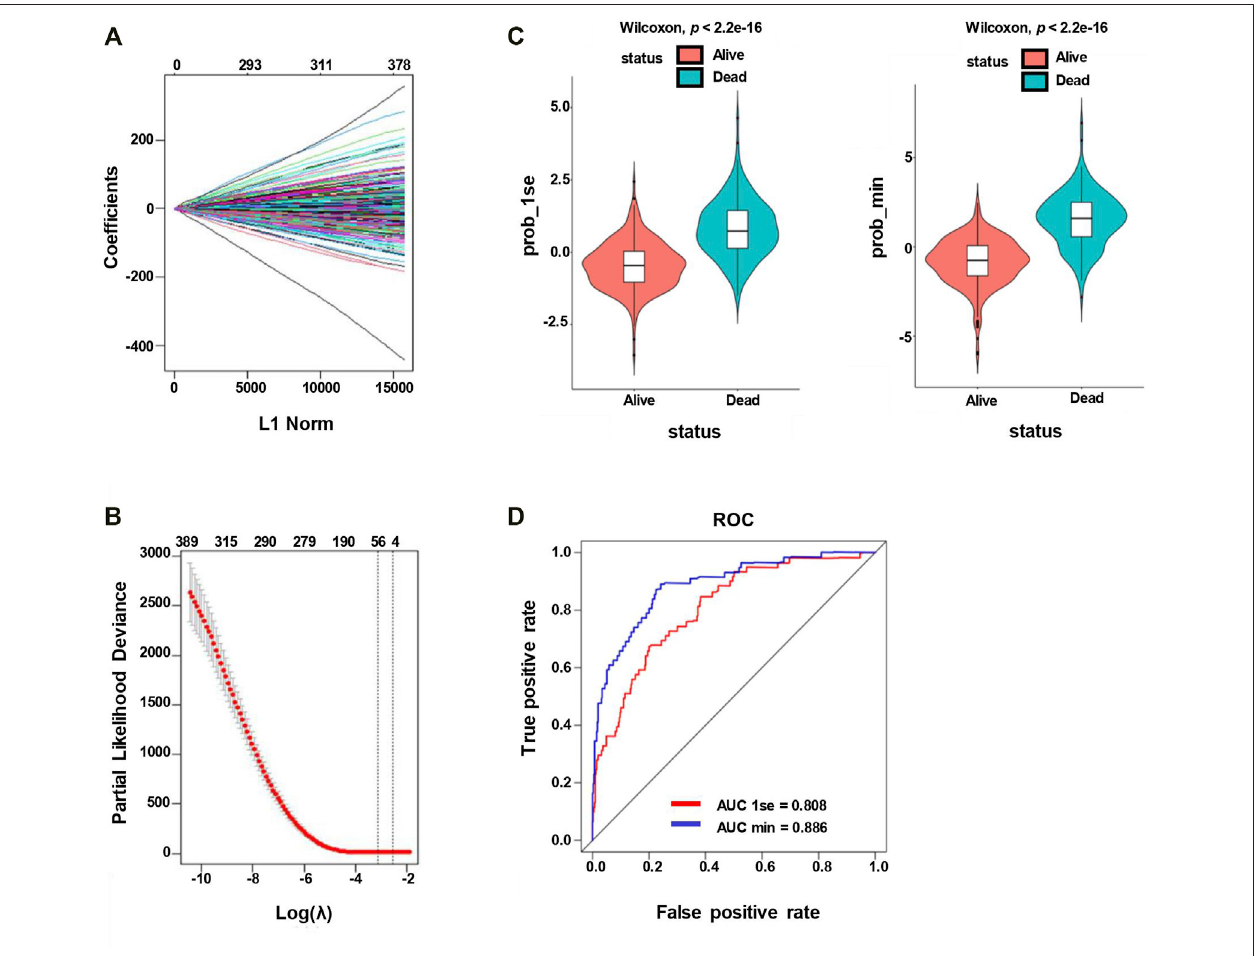
FIGURE 2 | Lasso penalized Cox regression analysis of SE-associated 512 genes. (A) Lasso coef fi cient pro fi les of the 512 SE-associated genes. (B) The identi fi cation of the best Lambda value. The left solid vertical line is the logarithm of lambda.min (48-gene group), and the right solid vertical line is the logarithm of lambda.1se (16-gene group). (C) The scatter plot of survival status of patients with diffuse large B-Cell lymphoma based on the 48-gene model (left, lambda.min, p < 2.2e − 16) or the 16-gene model (right, lambda.1se, p < 2.2e − 16) by the Wilcoxon test. (D) ROC curves are used to compare the predictive performance for prob- min and prob-1se to predict patient